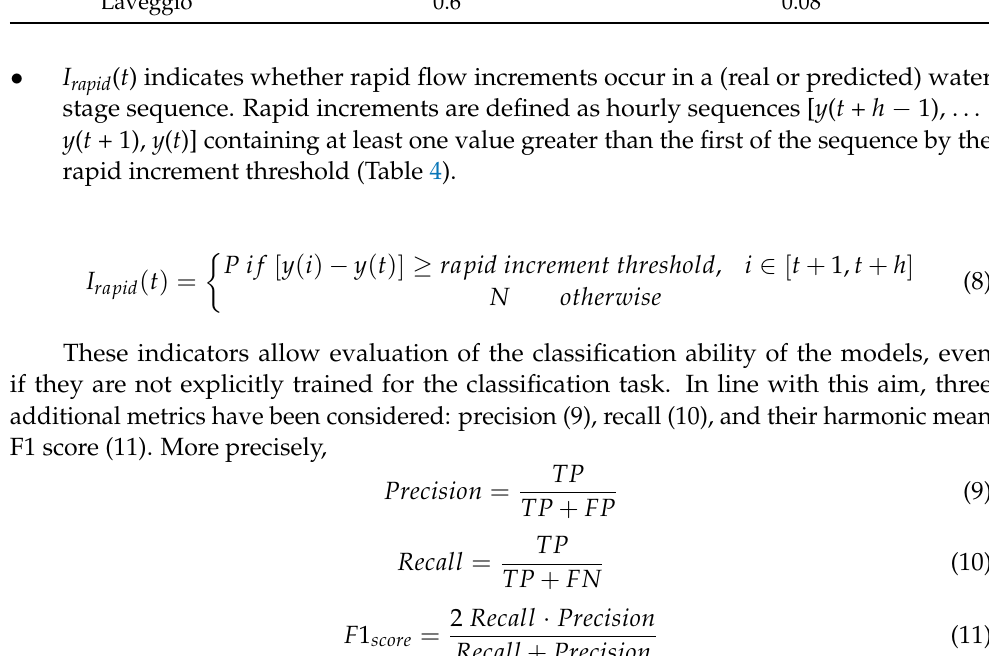
Table 4. Thresholds of floods and rapid events in Lura and Laveggio rivers for I flood and I rapid indicators. River Flood Threshold (m) Rapid Increment Threshold (m)